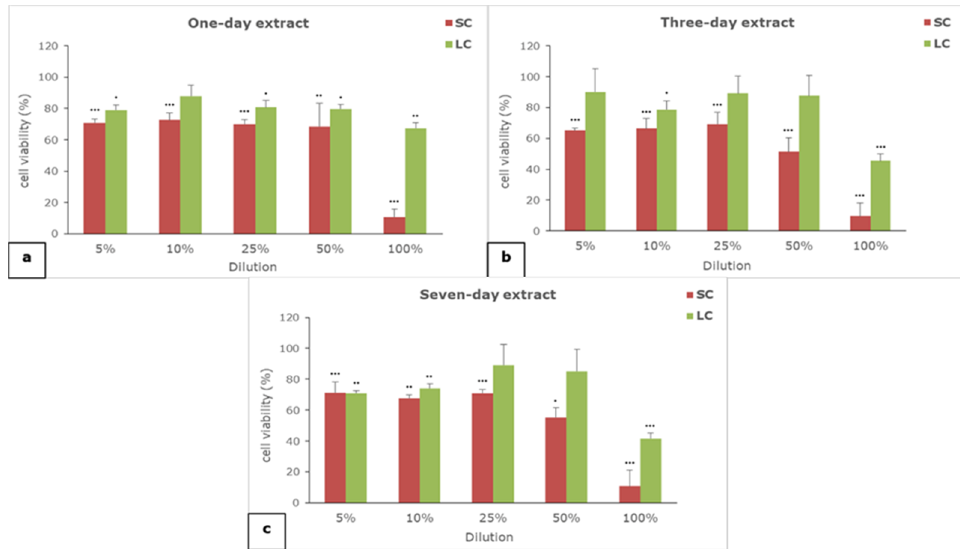
Figure 1. The effect of ( a ) one-, ( b ) three-, and ( c ) seven-day extracts of materials on the viability of L929 cells; SC—self-curing material; LC—light-curing material; (*) p < 0.05, (**) p < 0.01, (***) p < 0.001.